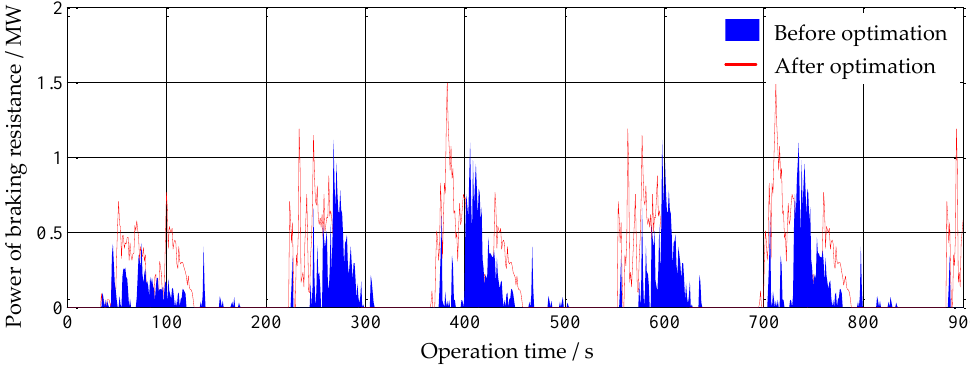
Figure 19. Power of Yizhuang Railway Station’s braking resistance before and after dwell time optimization.